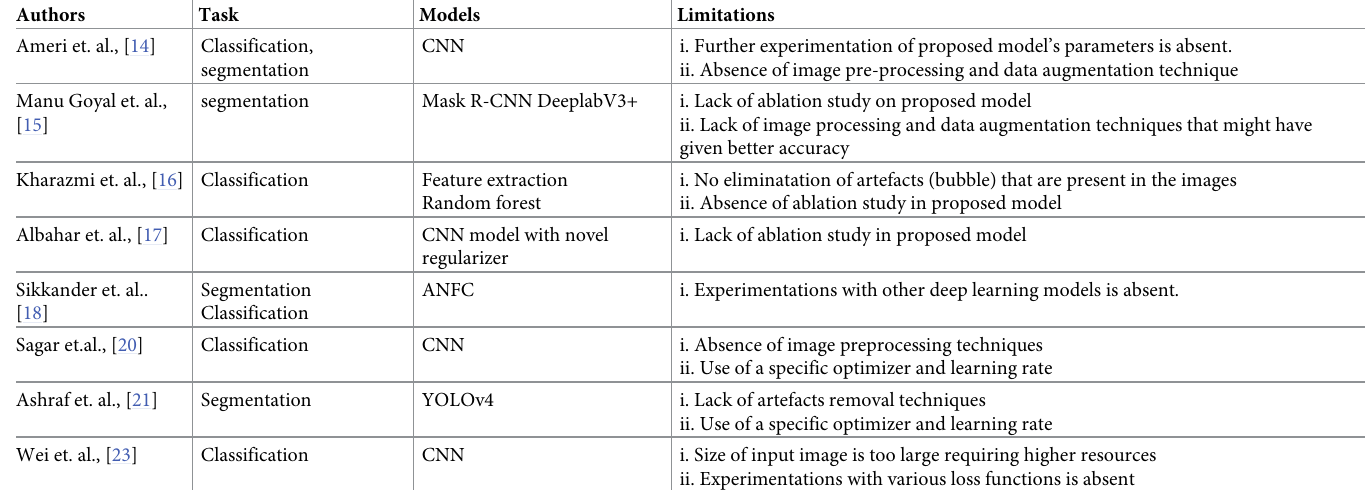
Table 1. A summary of the literature review showing the past techniques and their limitations.